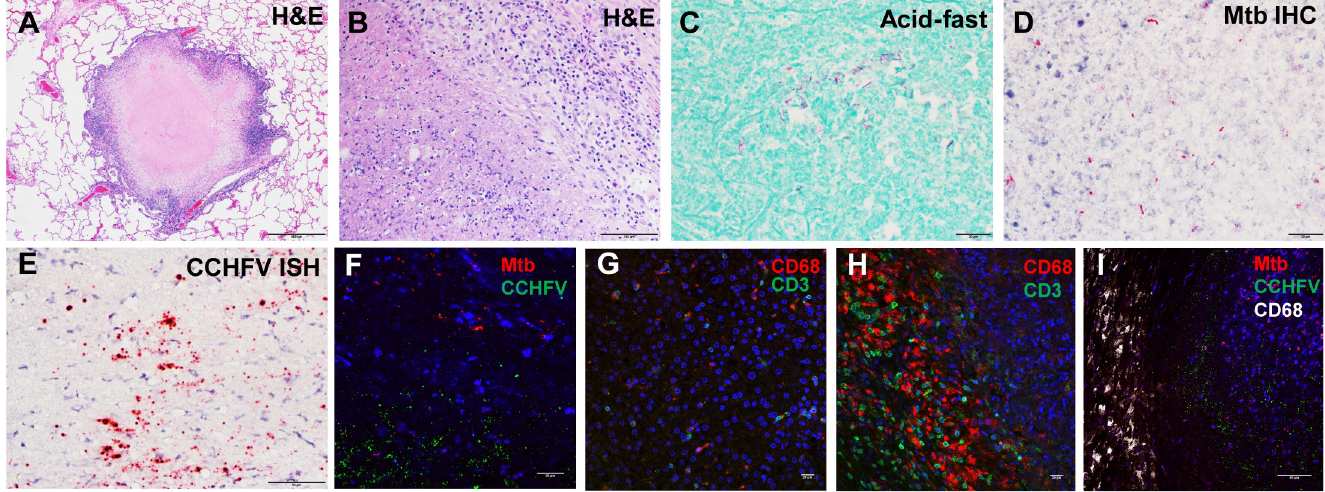
Fig 5. Histologic, acid-fast, IHC, ISH, and IFA findings in the tissues of CCHFV-infected cynomolgus macaques. A). Hematoxylin and eosin staining showed a granuloma in the lung. B). Hematoxylin and eosin staining of an animal with granulomatous inflammation in the liver. C). Acid-fast stain showed myriad bacilli ( Mycobacterium species ) are visible within the necrotic central area of a granuloma in the liver. D) IHC straining demonstrating that mycobacterium (red) is detected within the necrotic central area of a granuloma in the liver. E). Representative ISH staining demonstrating that CCHFV RNA (red) is detected at the periphery of the necrotic center of an animal with a lung granuloma. F). IFA demonstrating that both mycobacteria (red) and CCHFV (green) persist in a lung granuloma. G-H). Excessive number of T cell (green) and macrophages/monocytes (red) surrounds lung granuloma (H) in contrast to adjacent uninfected tissue (G). I). Neither CCHFV (green) nor mycobacteria (red) persists in CD68 + macrophages/monocytes (gray), which surrounds the lung